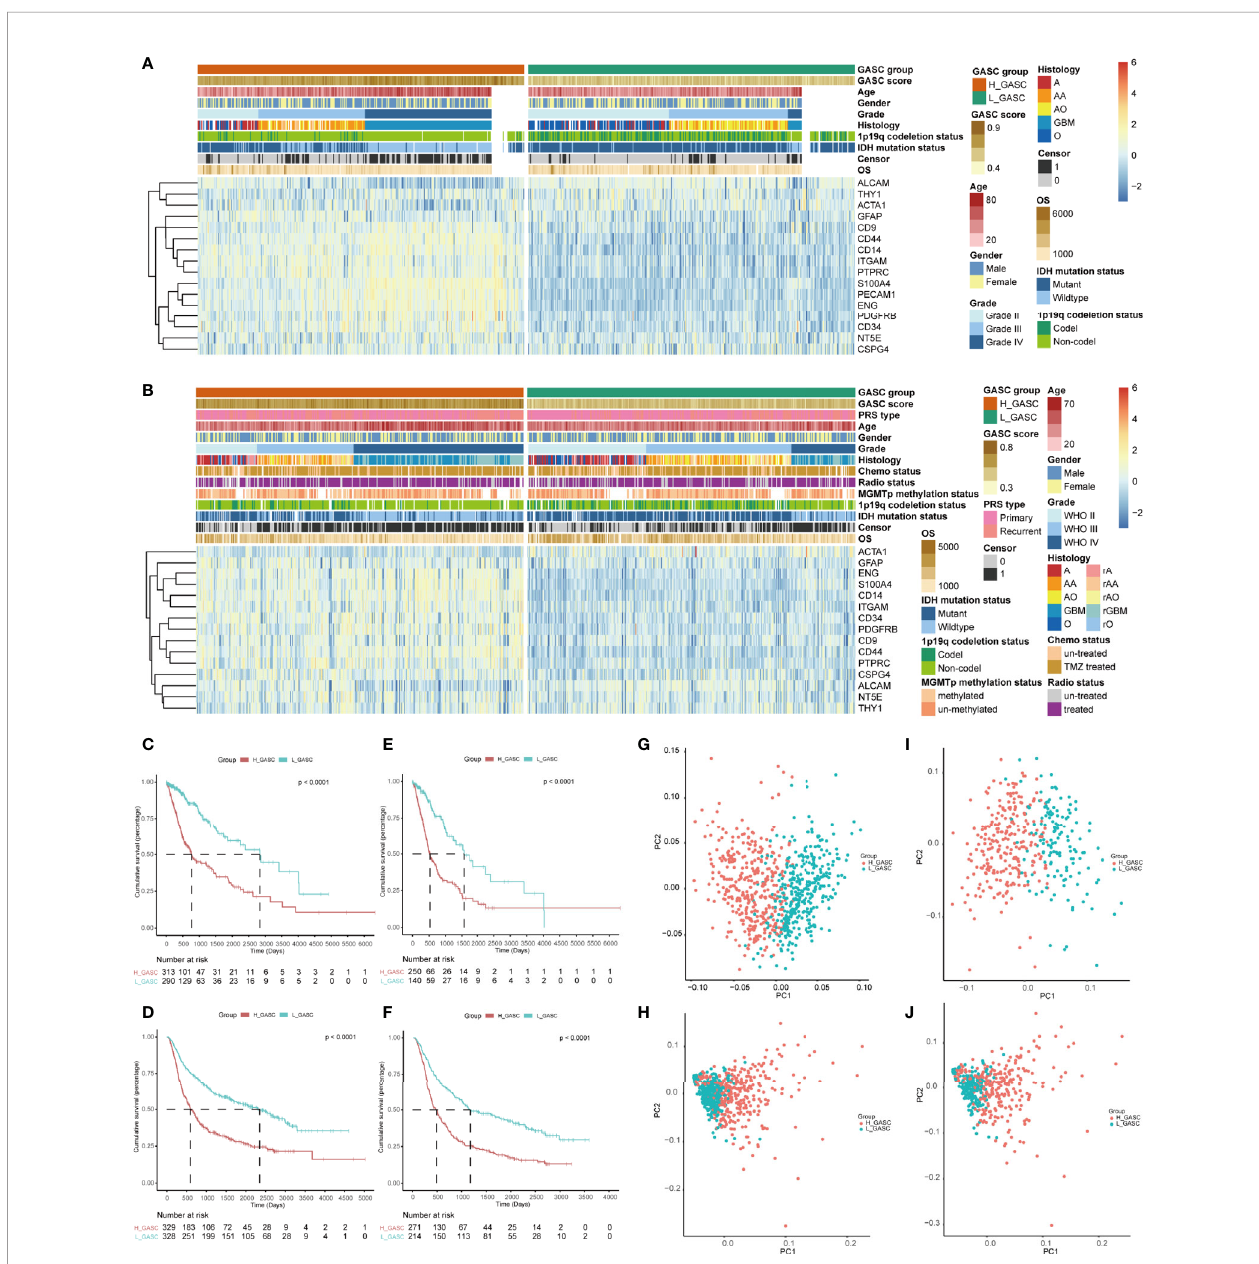
FIGURE 2 | Identi fi cation of high- and low-GASC groups. (A, B) Heatmap of GASC markers in all glioma population ( A for TCGA and B for CGGA). (C – F) Kaplan- Meier overall survival (OS) curves for samples in high- and low-GASC groups from all glioma population ( C for TCGA and D for CGGA) and high-grade glioma population ( E for TCGA and F for CGGA). (G – J) Principal component analysis of high- and low-GASC groups from all glioma population ( G for TCGA and H for CGGA) and high-grade glioma population ( I for TCGA and J for